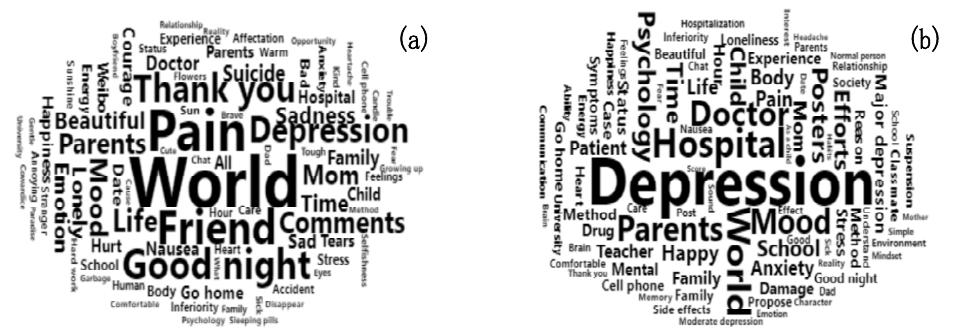
Figure 1. Keyword clouds in the lacking-management depression community (LDC) ( a ) and management depression community (MDC) ( b ).